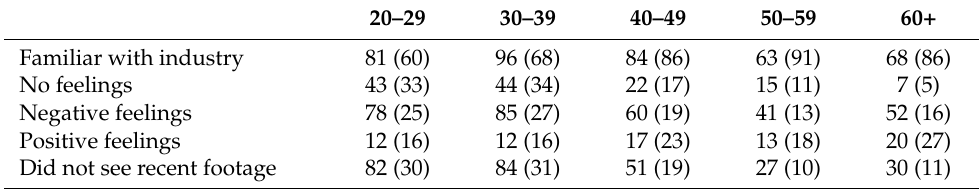
Table 7. Number of respondents (and per cent) in the different age categories that indicated that they were familiar with the industry, their feeling and whether they did not see the recent